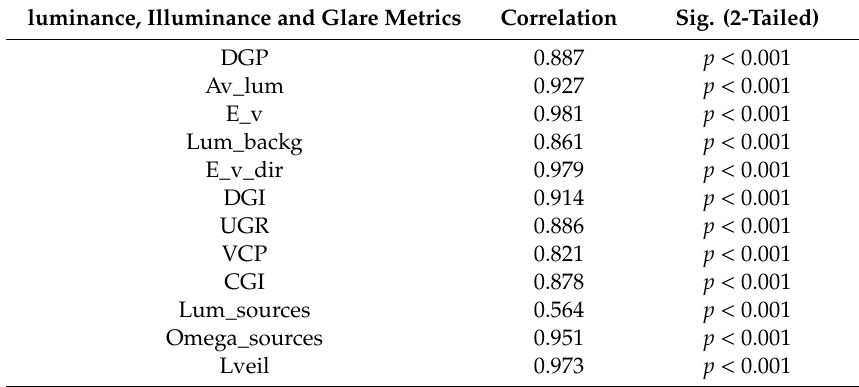
Table 4. Glare score results: the correlation and the significance between DSLR and Samsung S7 over 22